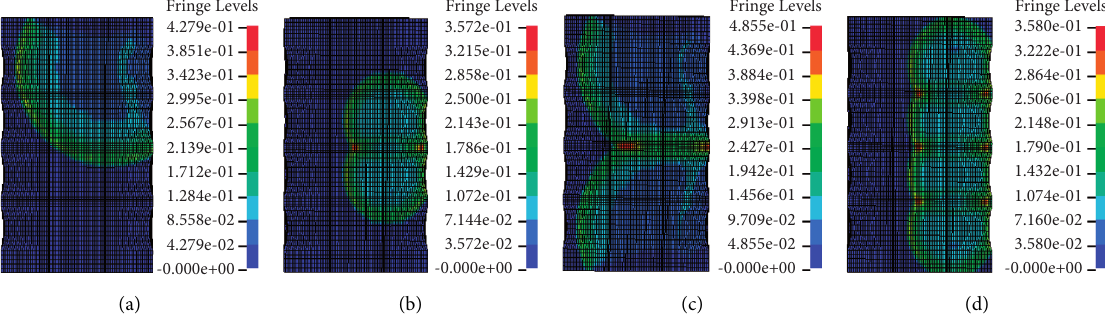
Figure 9: Pressure nephogram of single-column eccentric